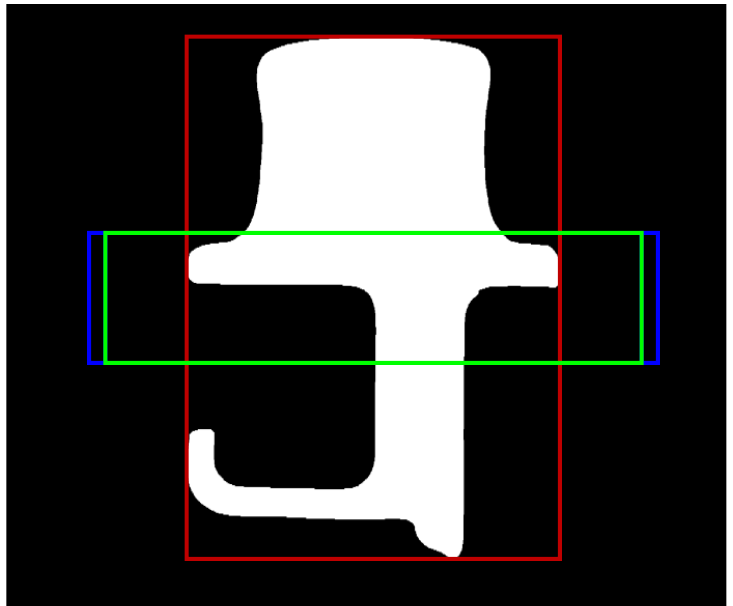
Figure 9. The test object ’ s initial position. The blue rectangle shows robotic fingers, the green rectangle is a possible grasping area, and the red rectangle is the object ’ s bounding box. Source: own.